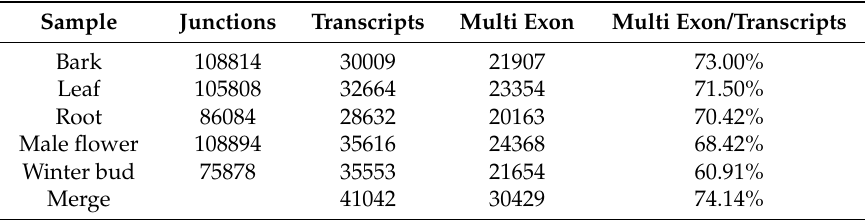
Table 2. Exon numbers of reconstructed